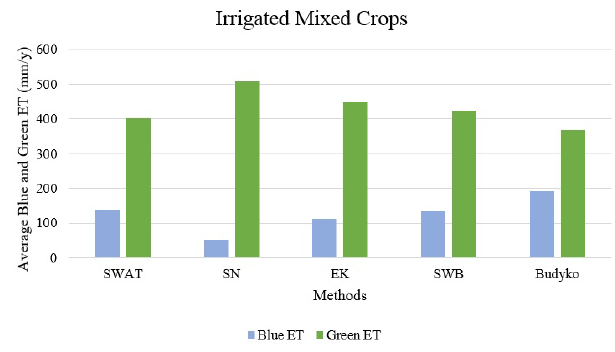
Figure 9. Blue and green ET comparison with the other four meth- ods from Msigwa et al.